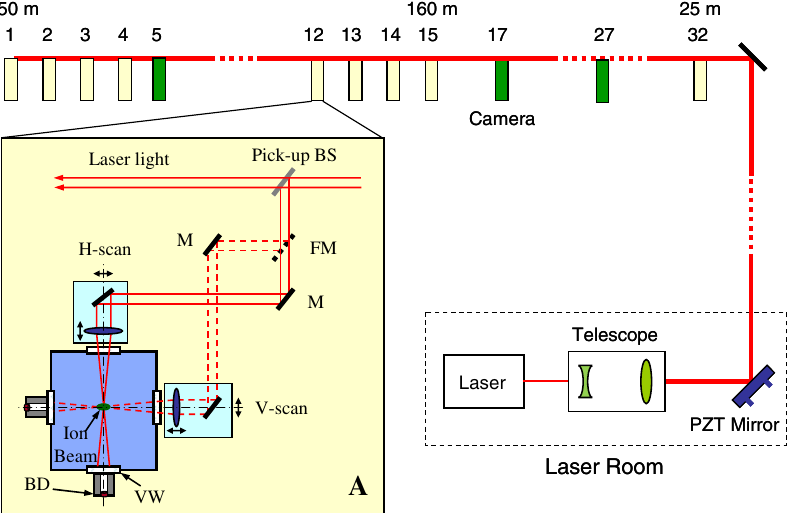
FIG. 1. Outline of the SNS laser wire system. PZT mirror: piezoelectric transducer driven mirror for beam position stabilization. The numbers in the figure indicate the SCL cryomodule and distances are from the laser source. Inset box A: diagram of an individual profile measurement station. BS: beam splitter; M: mirror; FM: flipper mirror; BD: beam dump; VM: vacuum